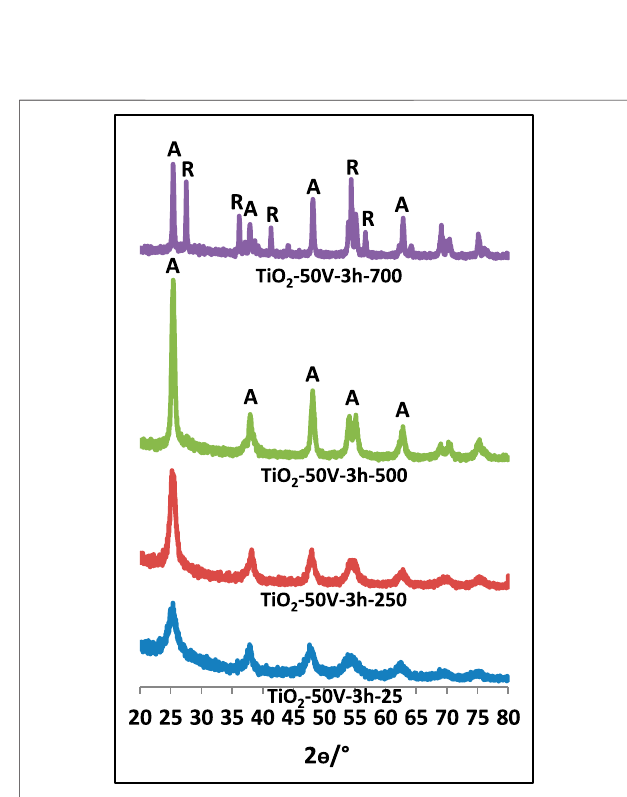
FIGURE 3 | XRD patterns of TiO 2 -50V-3h samples calcined at different